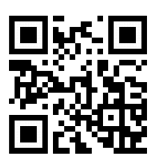
Figure 4. QR-Code. Figure 4. QR-Code.